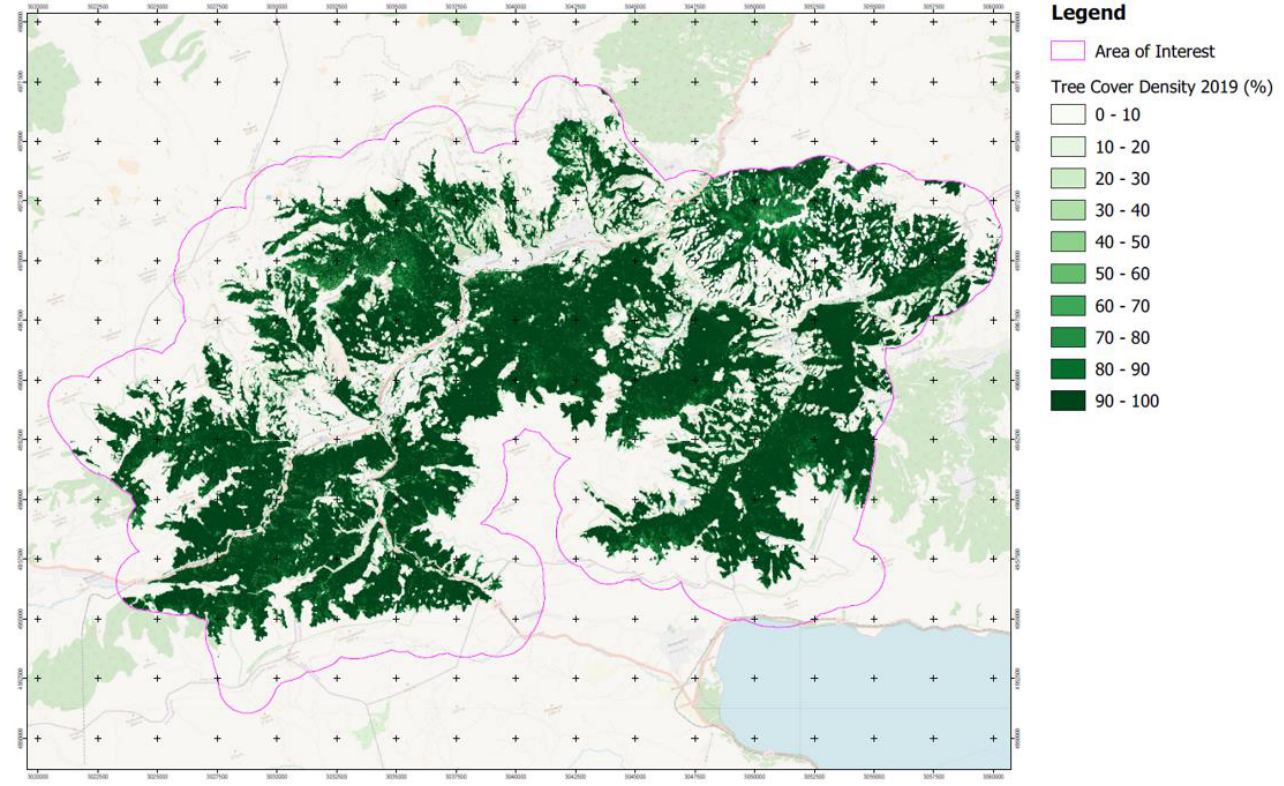
Figure 8. Forest Density year 2019.